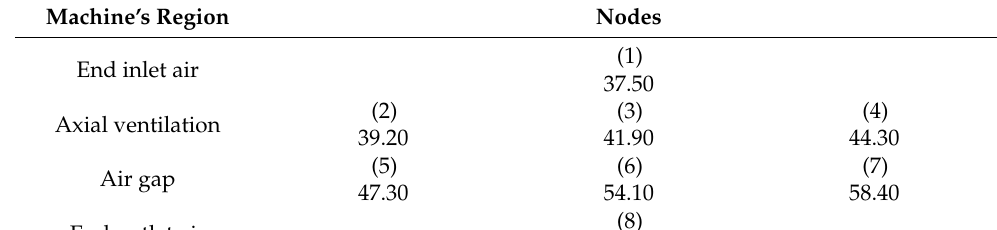
Table 10. Estimated cooling air temperature of A4 model.